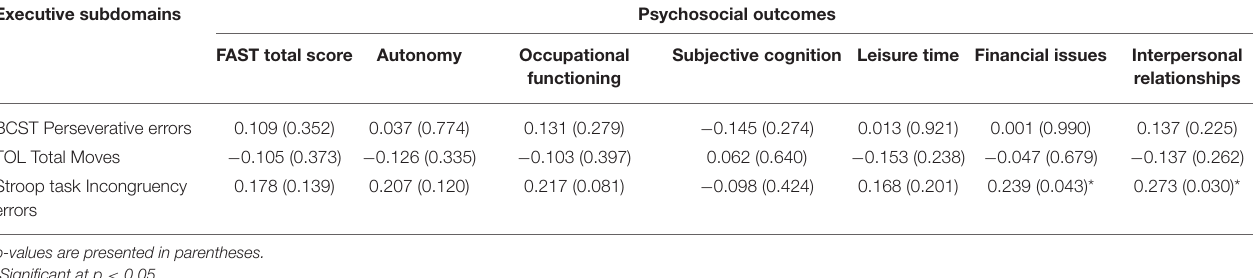
TABLE 2 | Domain specific relationships between executive subdomains and FAST outcomes in the healthy group ( N = 59), expressed by standardized Beta coefficients.